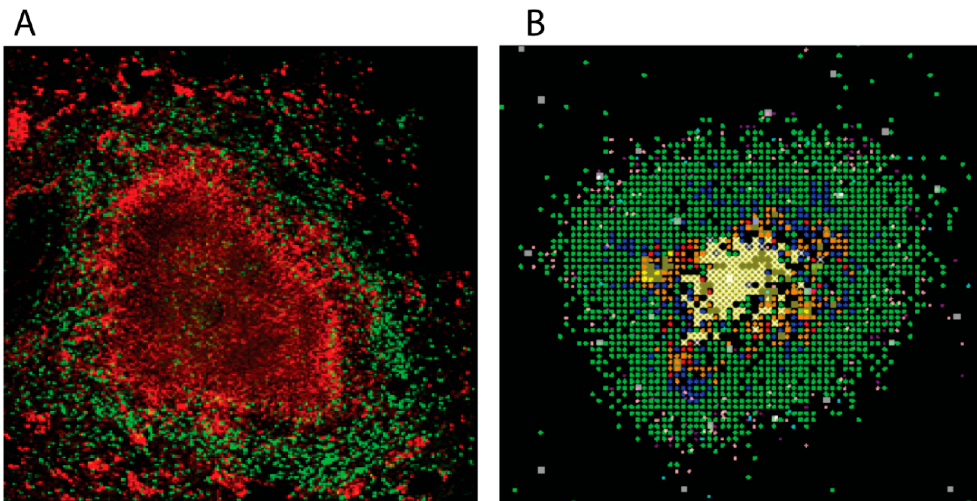
Figure 1. Non-human primate and simulated granulomas. Panel ( A ) Non-human primate granuloma stained for macrophages (Red CD68) and T cells (Green CD3). The very center (black, no staining) is caseous necrosis (Image courtesy of Dr. Josh Mattila, University of Pittsburgh). Panel ( B ) GranSim outputs. 2D snapshot, zoomed in to show detail showing macrophages (green-resting, blue-activated, orange-infected, red-chronically infected), T cells (pink IFN-g producing, purple-cytotoxic, white-Tregs), extracellular bacteria (yellow), necrosis (brown areas).